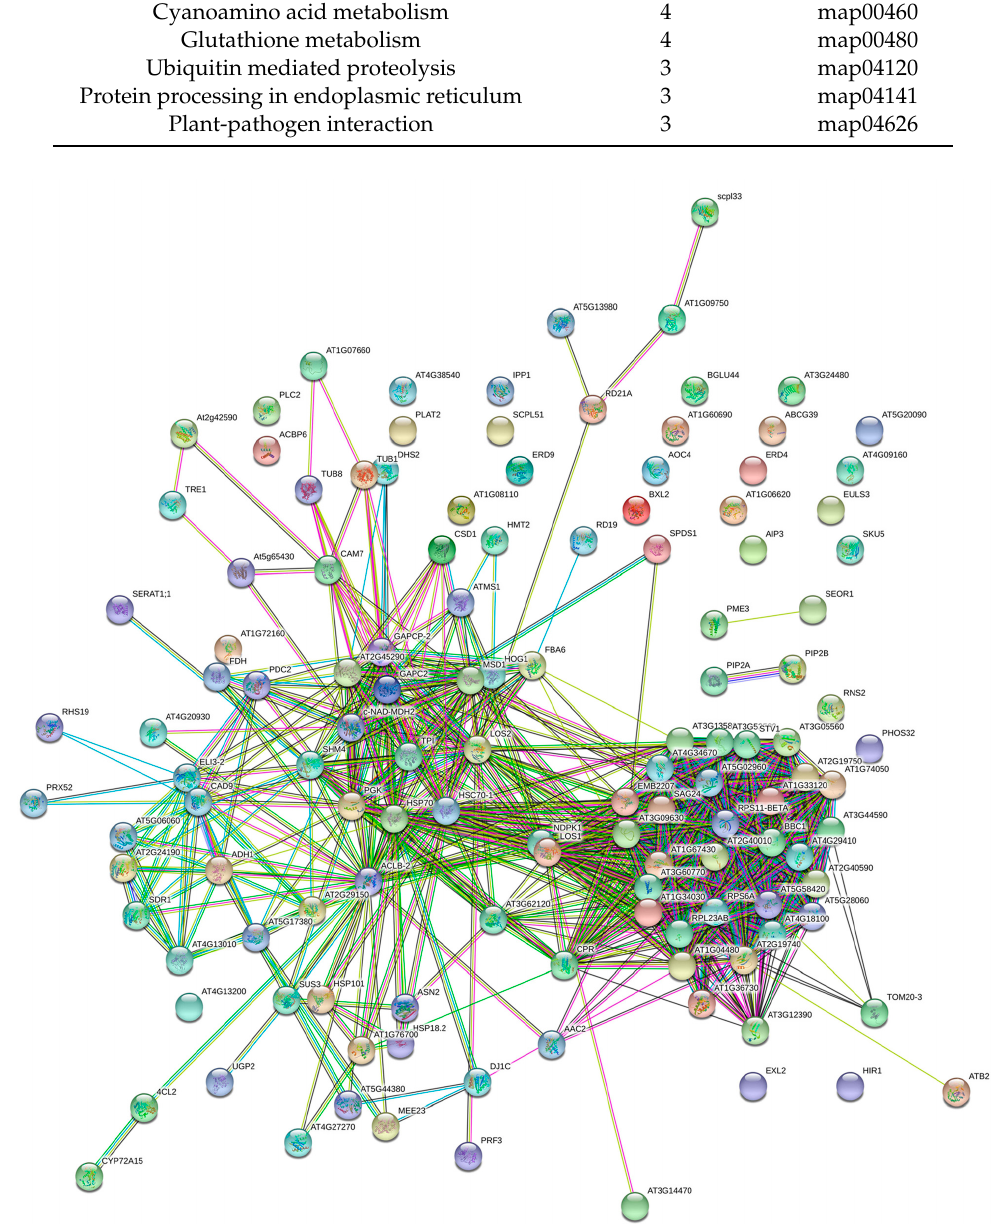
Figure 5. Interaction network analysis of differential expression of proteins. In this network, nodes are proteins, lines represent functional associations between proteins, and the thickness of the lines represents the level of confidence in association reported.